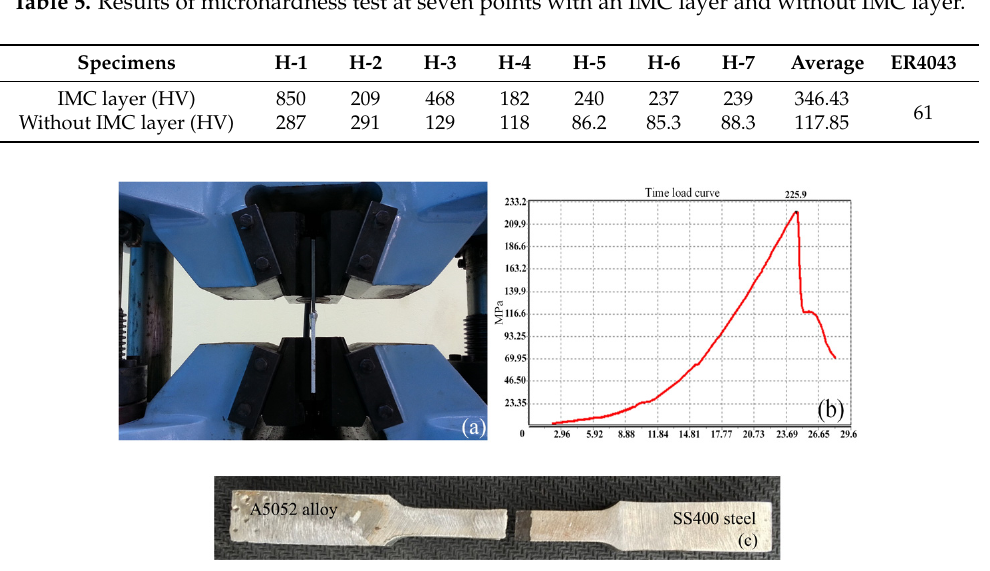
Table 5. Results of microhardness test at seven points with an IMC layer and without IMC layer.